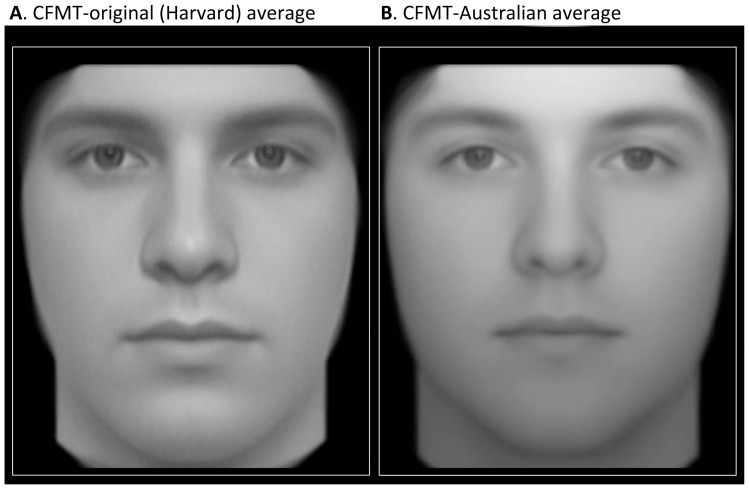
Average faces.
A. Average face created via morphing procedures from the individuals included in the CFMT-original (Harvard/Boston). B. Average face created via morphing procedures from the individuals included in the CFMT-Australian (Canberra, Australia). The image sizes are matched for distance between eyes. The white boxes are identical to facilitate comparison of face width. Note the many differences in both local features and aspects of global face structure. Figure adapted from [25], where method of creating the averages is described.